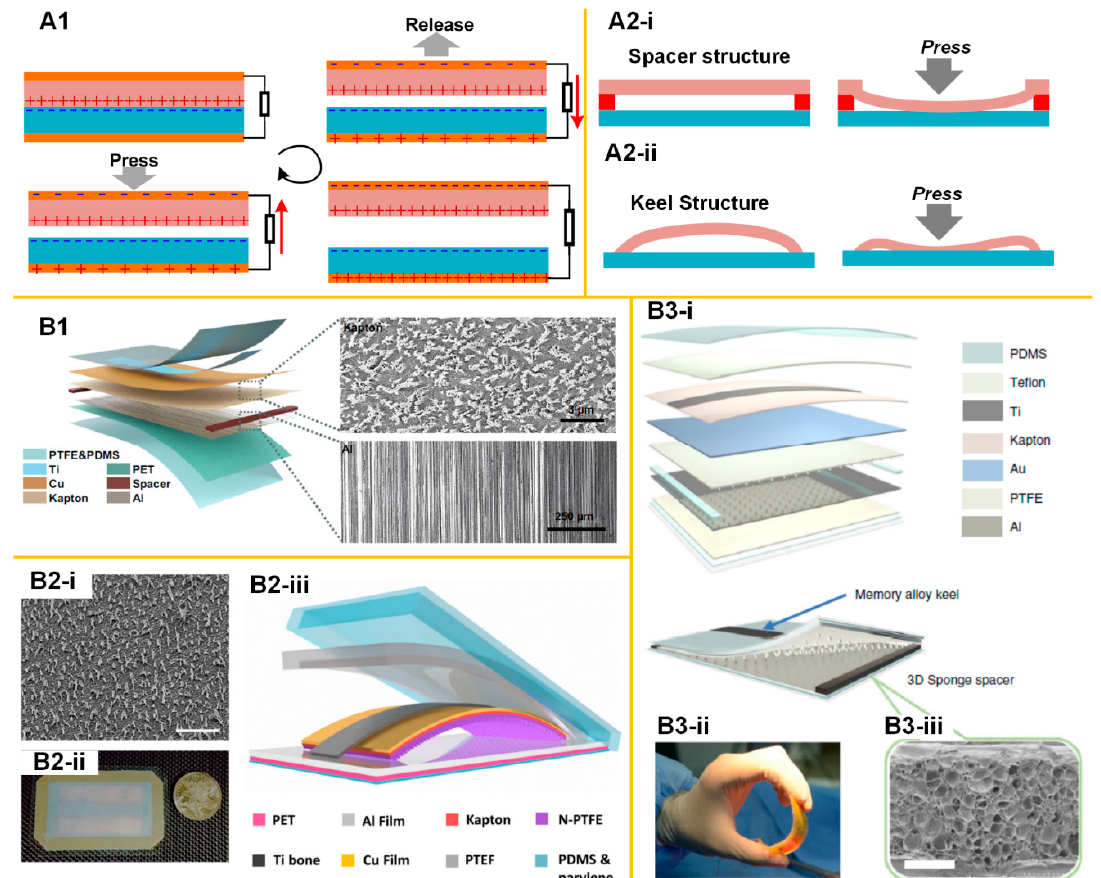
Figure 4. The mechanical structure of implantable thin-film TENG devices. ( A1 ) The working principle of the TENG device; ( A2 ) The mechanical structure applied for automatic recovery after pressing; ( B1 ) The device with spacer and backbone structures [62]; ( B2 ) The device with keel structure. Reproduced with permission from [63]. Copyright 2016 American Chemical Society; ( B3 ) The device with the integration of both the spacer and keel structures [64].